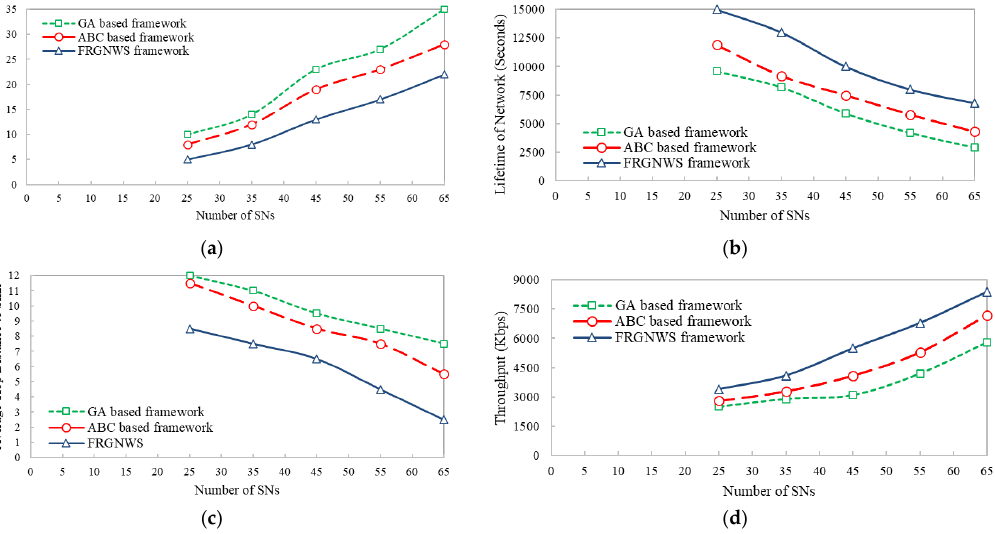
Figure 5. The outcomes of the set of simulation experiments conducted with variations in the number of SNs: ( a ) number of RNs with variations in the number of SNs; ( b ) lifetime of the network with variations in the number of SNs; ( c ) average hop distance to the sink with variations in the number of SNs; and ( d ) throughput with variations in the number of SNs. Table 3. The average % effectiveness of the proposed novel framework for the number of RNs metric with variations in the number of